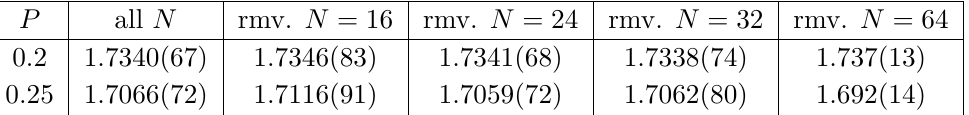
Table 5. Values of c mix for W mix with data for different N removed. With n t = 16 .